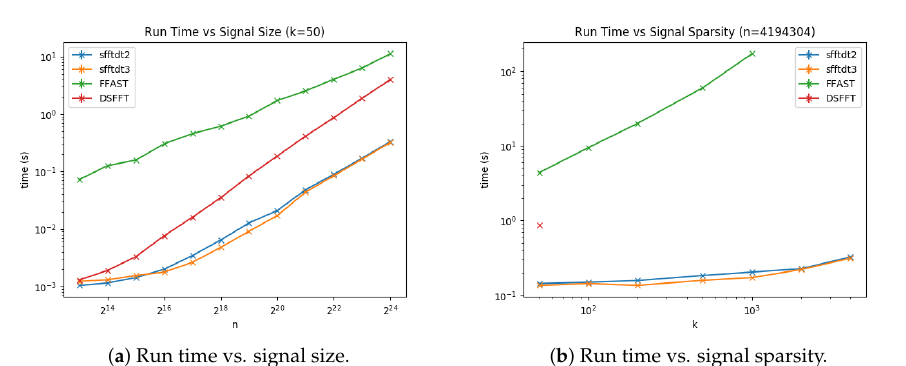
Figure 7. Run time of four algorithms using the aliasing filter, including the sFFT-DT2.0, sFFT-DT3.0, R-FFAST, and DSFFT algorithms in the general sparse